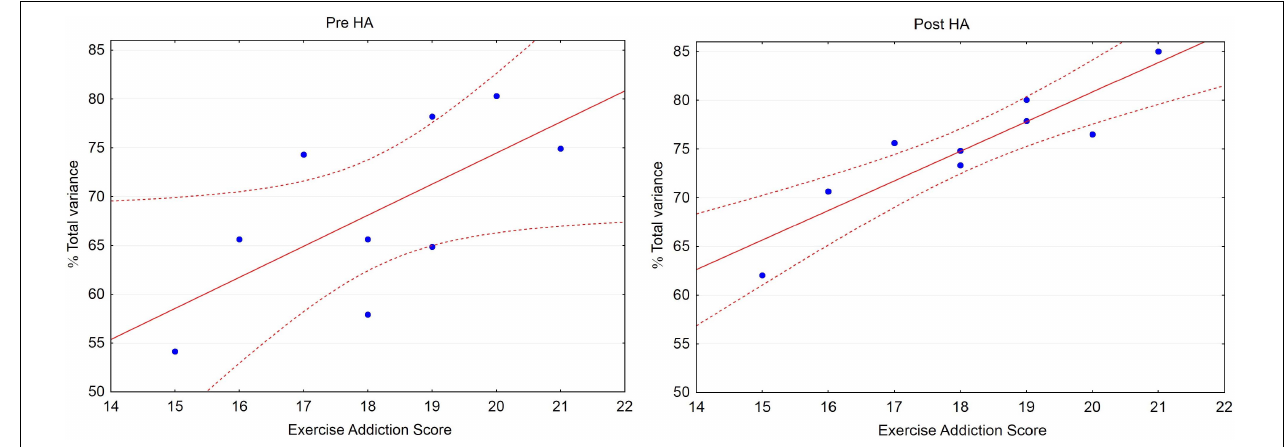
FIGURE 1 | Scatterplot: Percentage of total variance explained by PC1 (% Total variance) vs. Exercise Addiction Score (EAS). Pre-HA: Correlation: r = 0.67 ( p = 0.049), % Total variance = 10.79 + 3.18 EAS. Post-HA: r = 0.90 ( p = 0.001), % Total variance = 20.03 + 3.04 EAS. Dashed lines depict 95% confidence